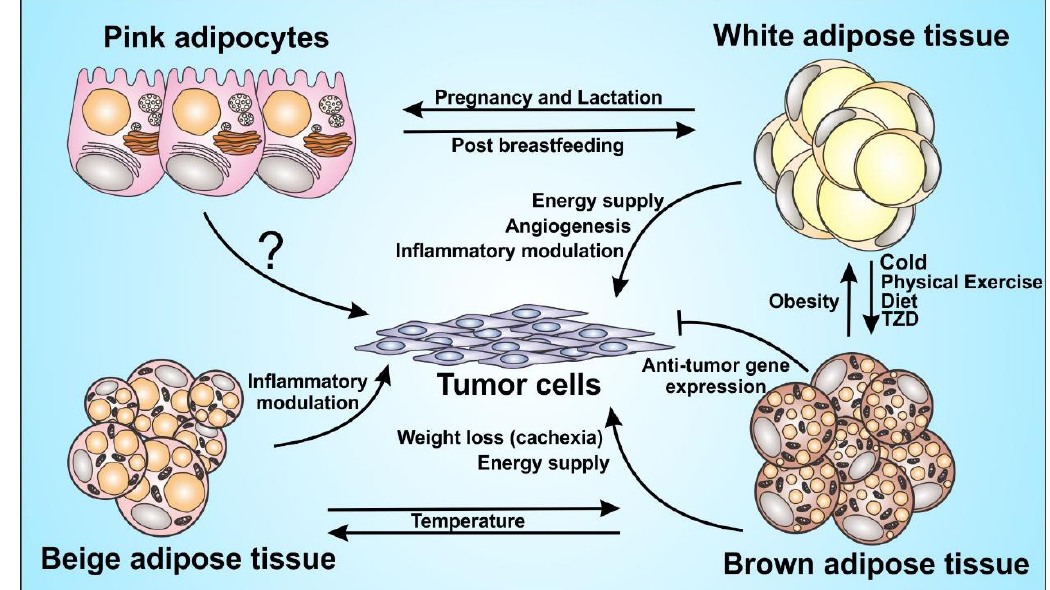
Figure 1. Adipocytes function in tumor progression. Adipocytes play a major role in the inflammatory modulation and endocrine function. It acts directly and/or indirectly on tumor progression, although some mechanisms are still unknown, such as the role of pink adipocytes on the tumor cells. The figure shows the great plasticity between brown, beige and white adipocytes with the influence of some inducers and the capacity of those cells to orchestrate the tumor microenvironment, through energy supply and immunomodulation.